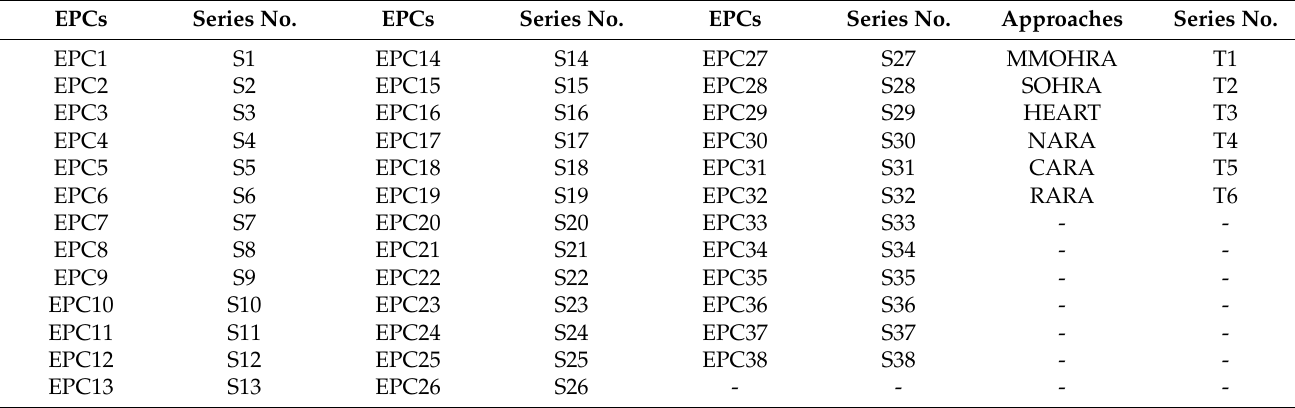
Table 2. Simple notation of EPCs and